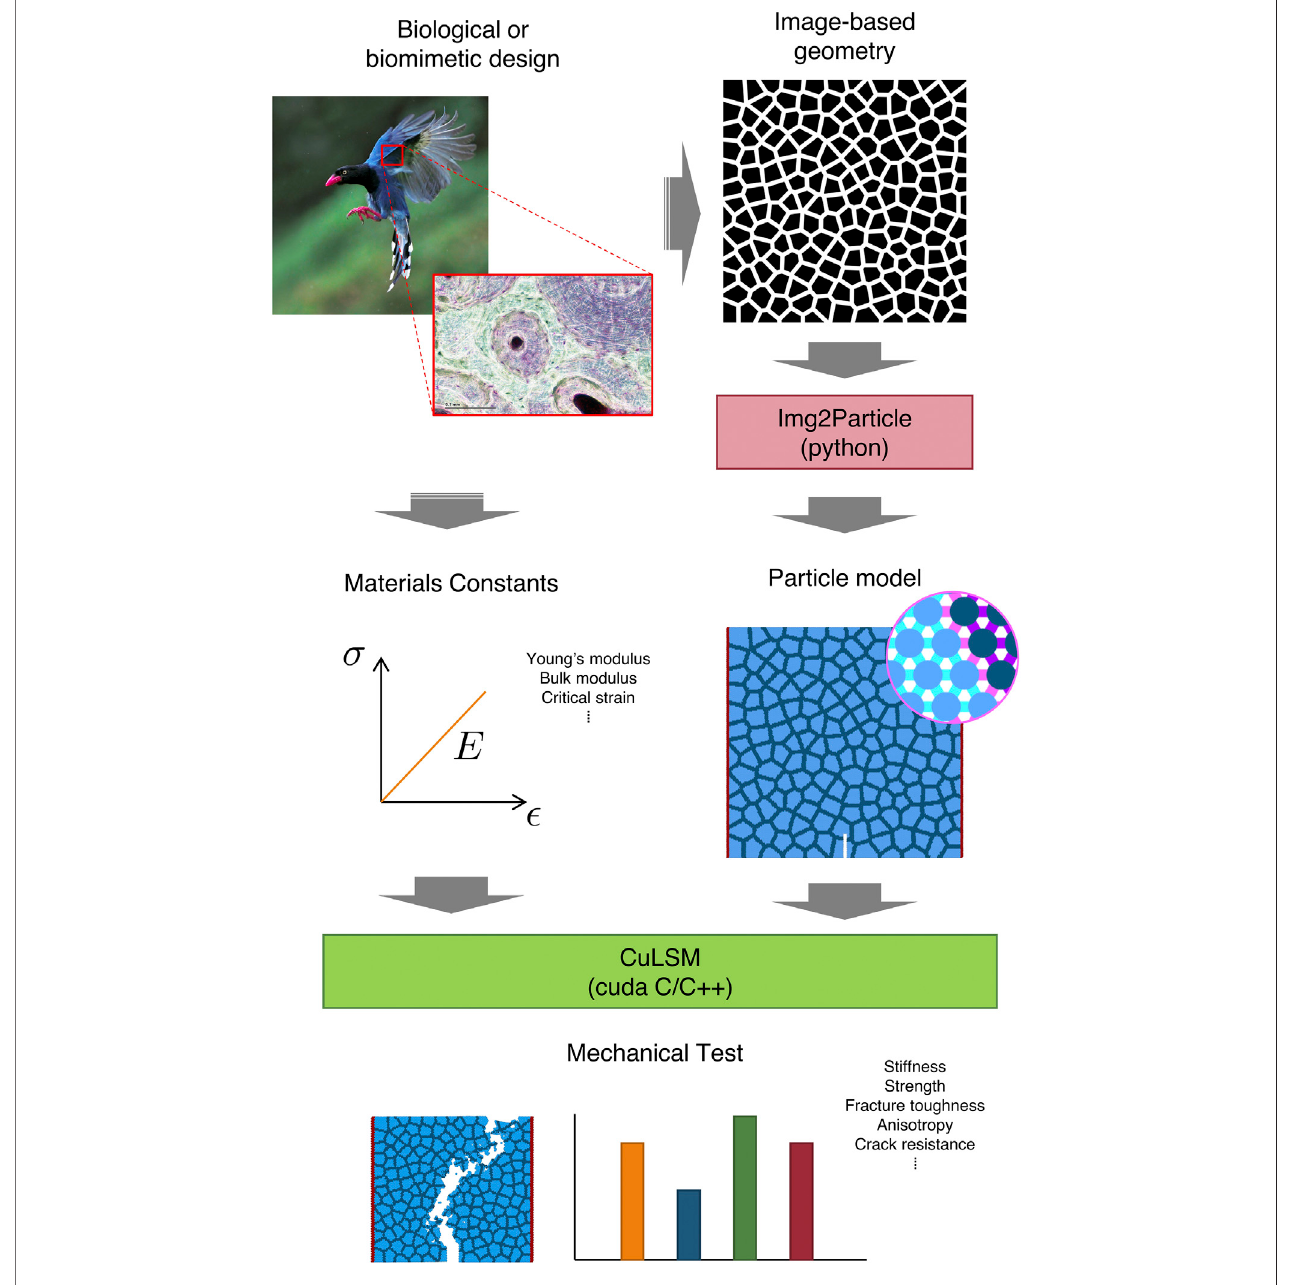
FIGURE1| ImageMechplatformfromimagetomechanicalproperties.Taiwanbluemagpie( Urocissacaerulea )(photocredit:John&FishonFlickr,CCBY-NC-ND 2.0). Cross section of bird bone (photo credit: Josef Reischig, CC BY-SA 3.0).